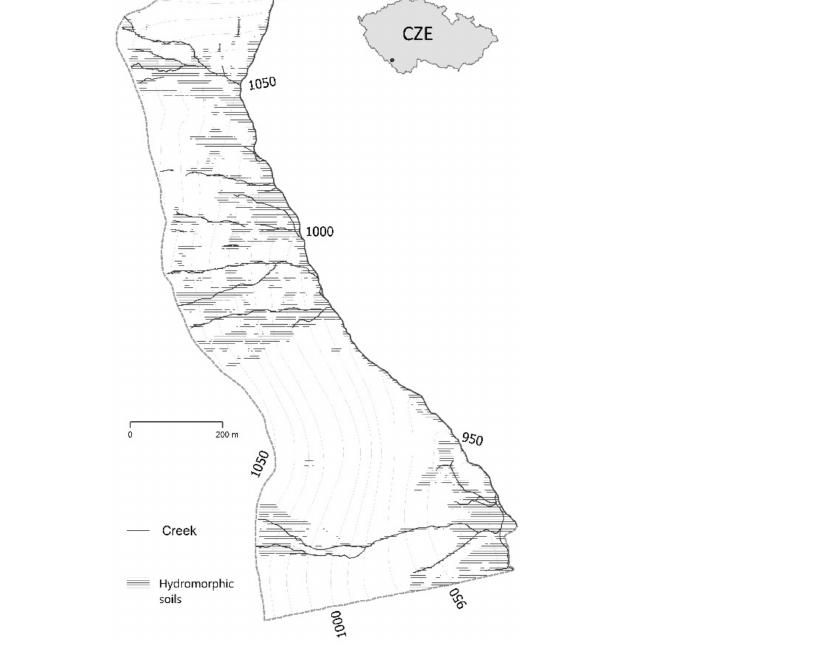
Figure 1. Map of the Boubin old-growth forest and location within the Czech